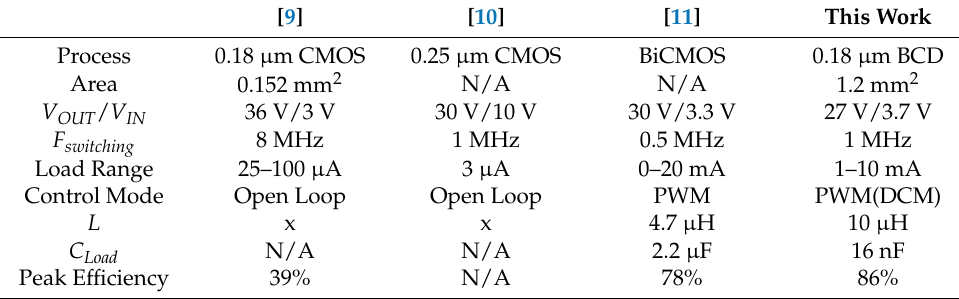
Figure 11. Simulated waveforms of proposed boost converter. Table 1. Performance comparison.